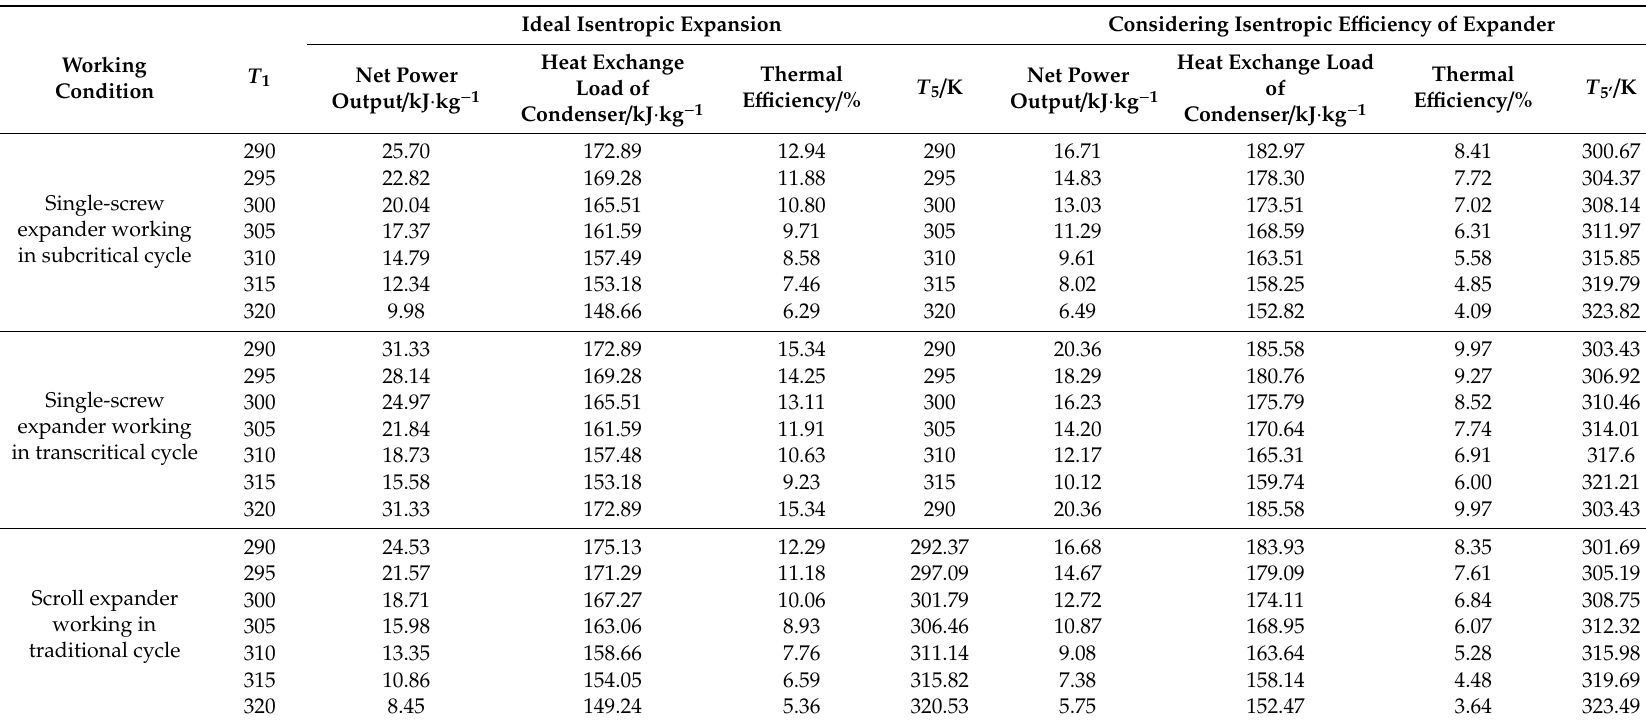
Table 8. Comparison of thermodynamic performance of R1234ze(E) with and without consideration of the isentropic e ffi ciency of the